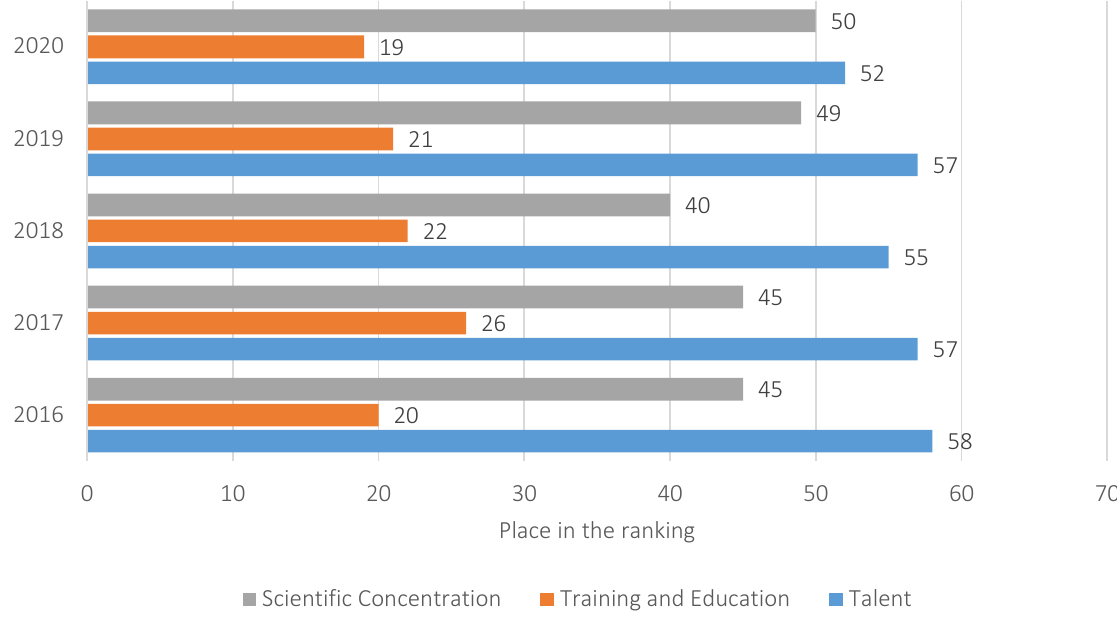
Figure 4. Dynamics of Ukraine’s place by sub-factors of the knowledge